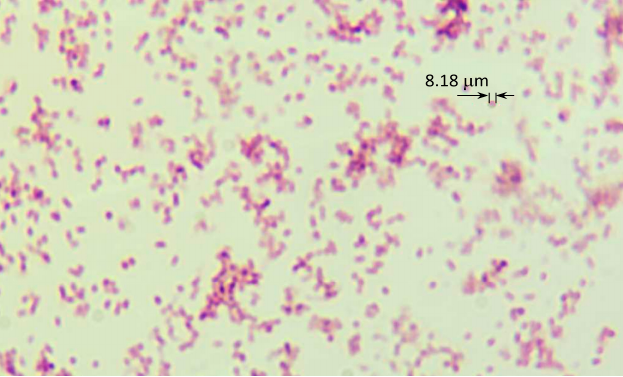
Figure 5. The microscopic image of suspension with Staphylococcus aureus —optical density 6.25 McF.